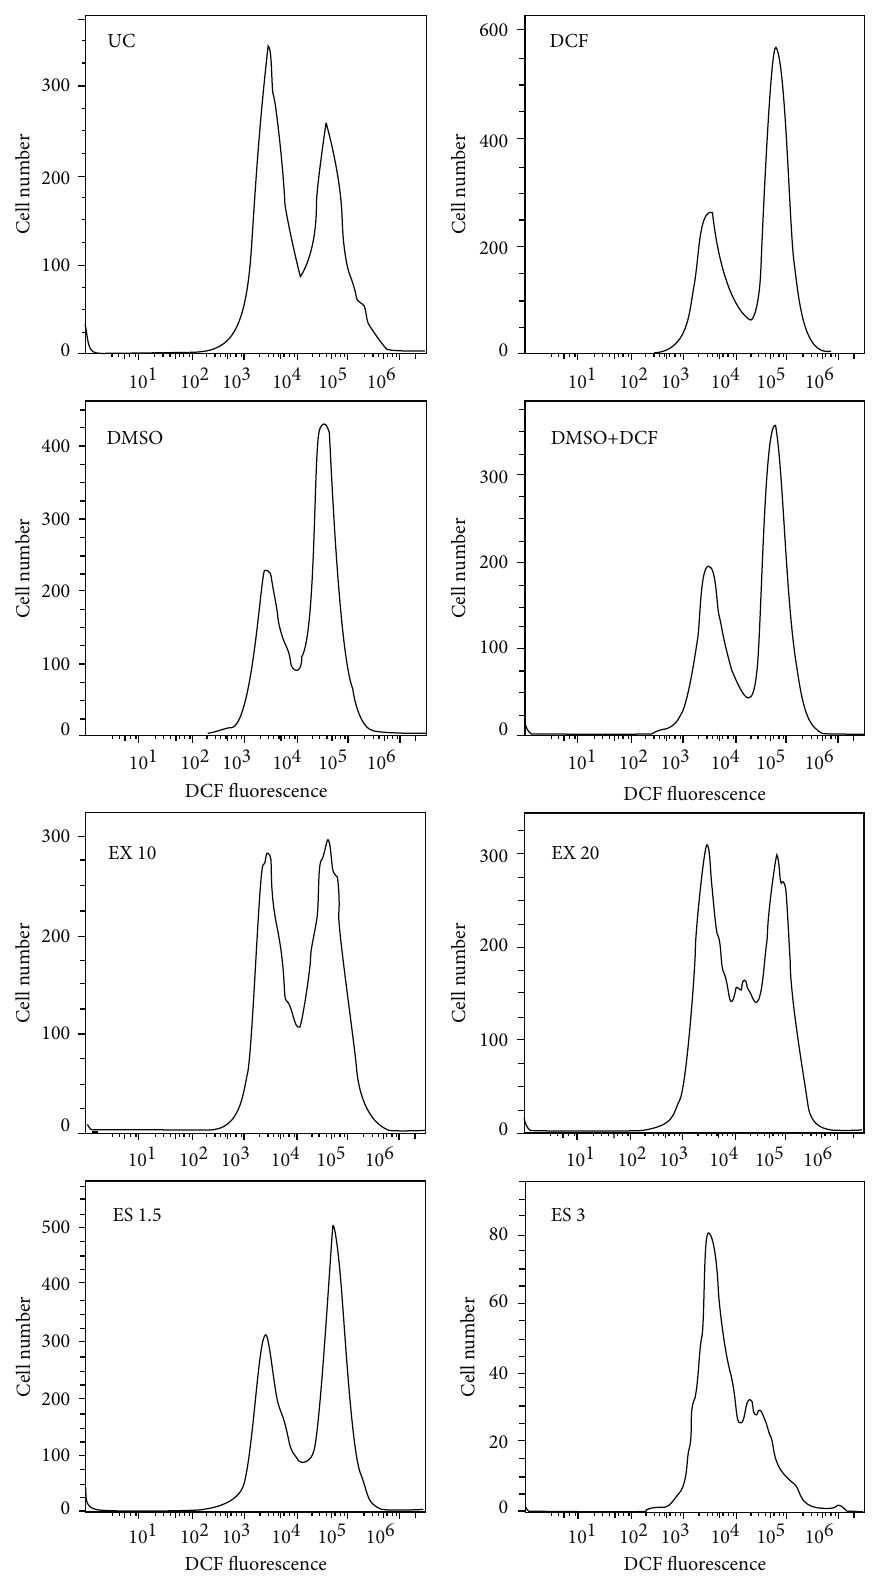
Figure 6: Histogram of ROS measured by fl ow cytometry (quantitative histogram due to changes in the mean fl uorescent intensity of DCFH-DA probes compared to cells without extract and essential oil) (UC: untreated cell; DCF: cell with DCF; ES: essential oil; EX: